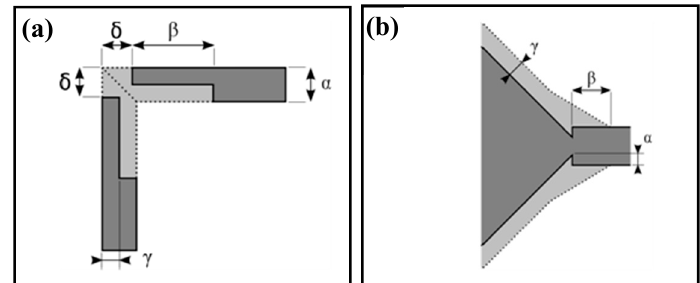
Figure 6. Layout of the compensation structures and definition of parameters: ( a ) layout Q for intersection of perpendicular channels; ( b ) layout I for intersection of channel with cavity. Dotted line and gray area shows the projected etch profile. The dark gray area is the open area of the etching mask.